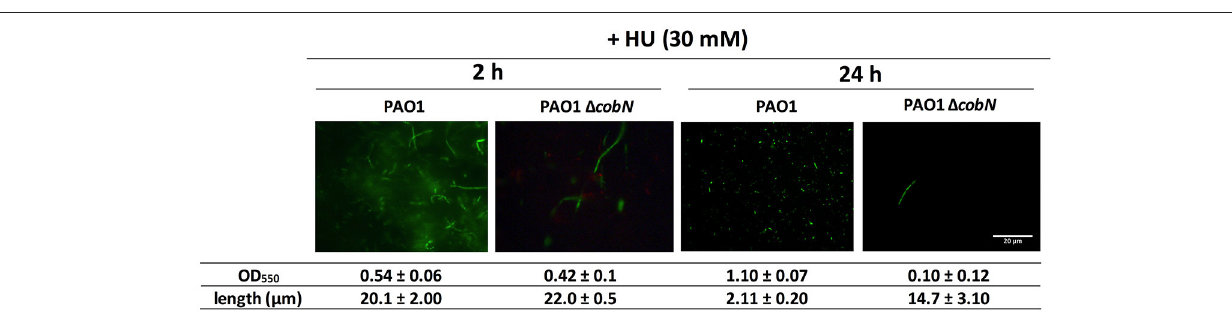
FIGURE 3 | Cell morphology after hydroxyurea treatment. Fluorescence microscopy images from aerobic P. aeruginosa PAO1 wild-type and 1 cobN growth visualized after 2 and 24h of HU treatment. Cells were stained with the LIVE/DEAD BacLight Bacterial Viability Kit, and the bacterial length was measured using ImageJ software. The images represent at least three different experiments. Scale bars, 20 µ m.